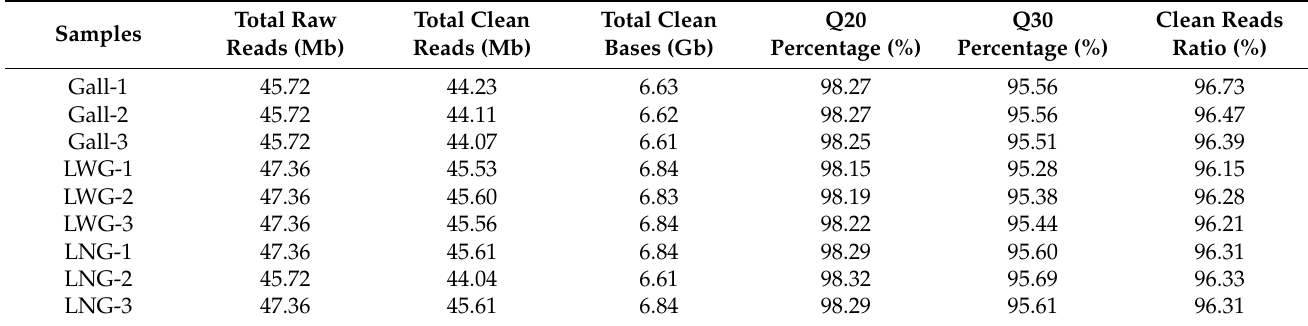
Table A2. Quality evaluation of clean reads.